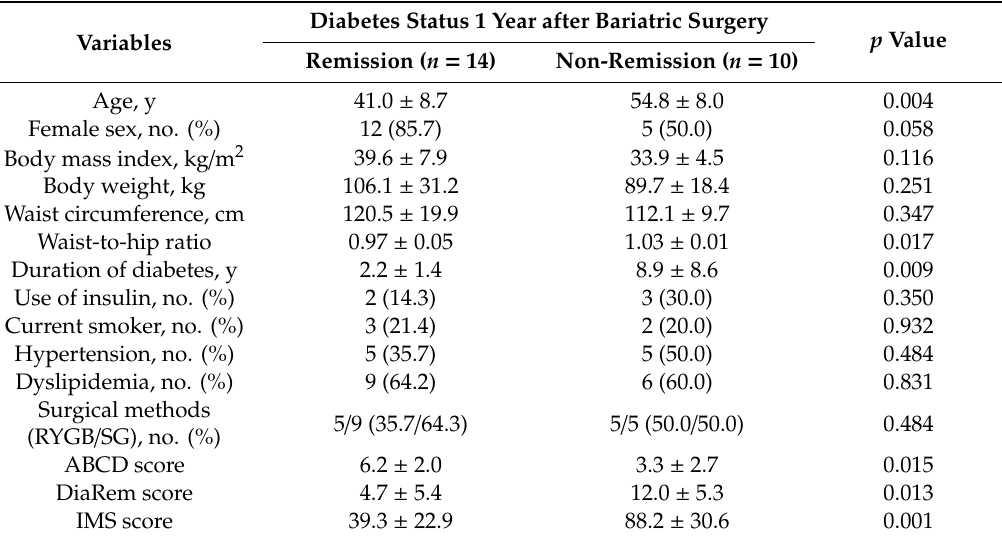
Table 1. Baseline